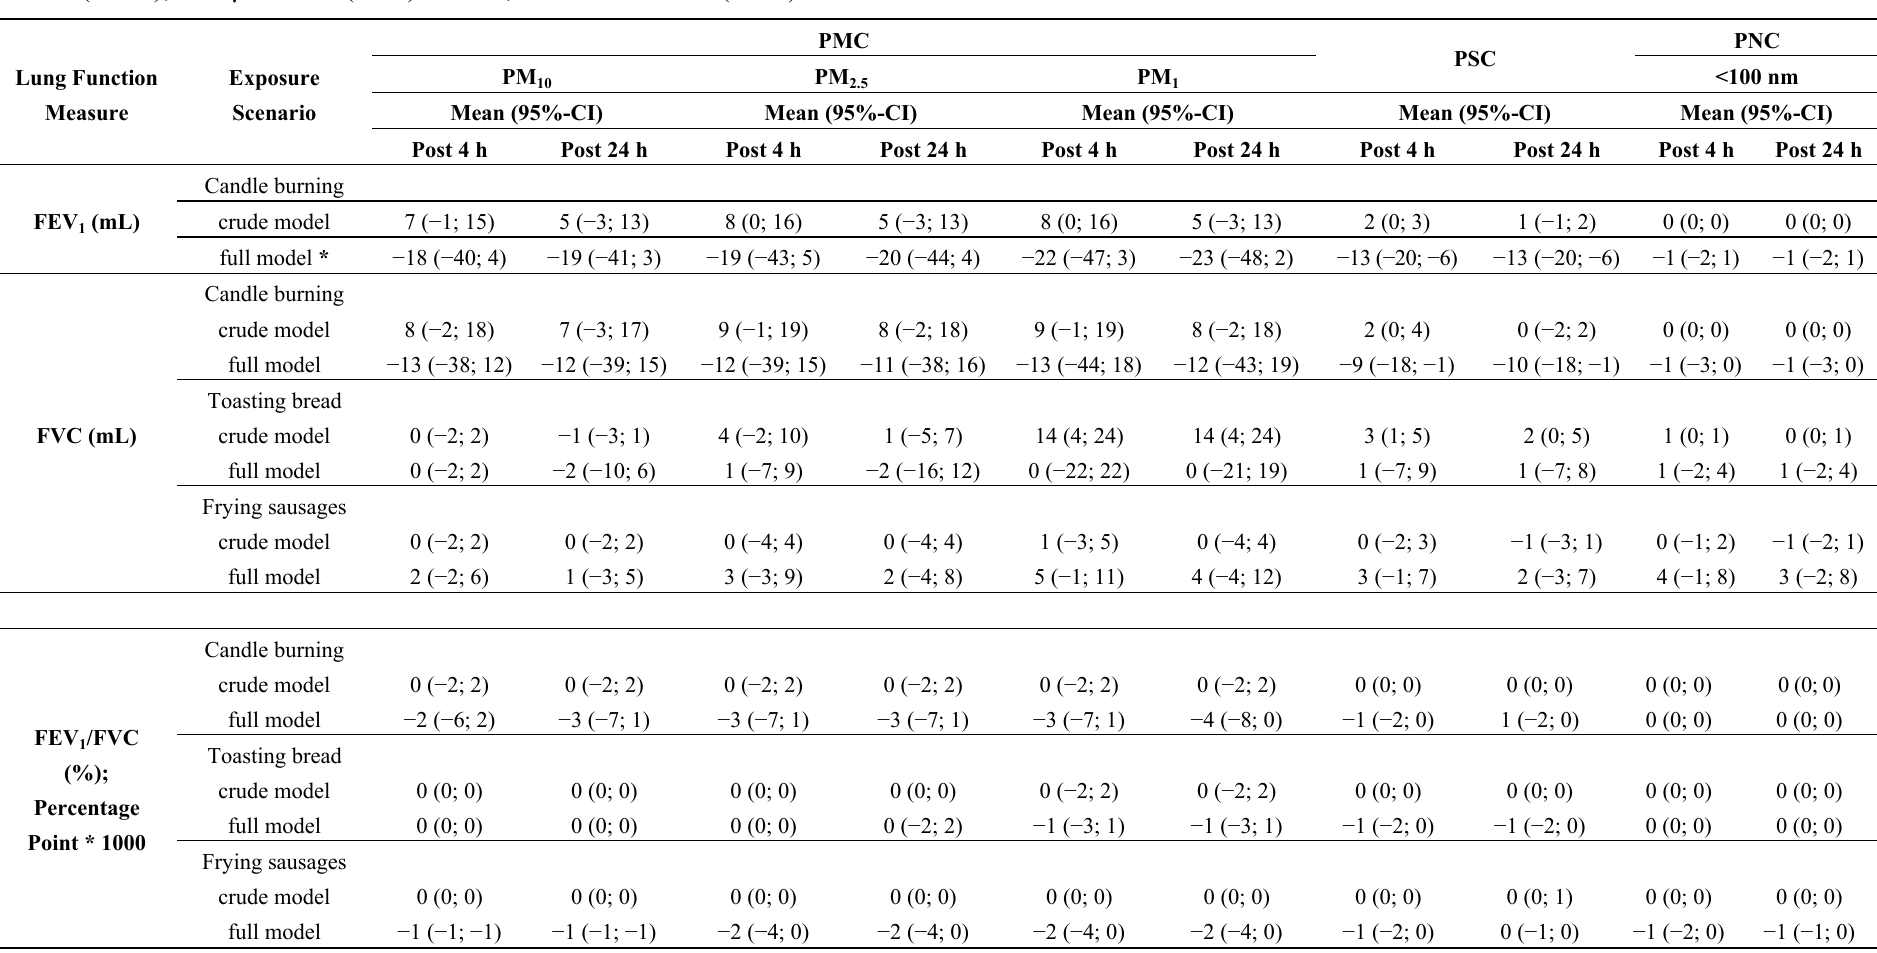
Table 4. Mean effect estimates and 95% Confidence Intervall (CI) for changes (difference) associated with an increase in particulate metrics post 4 h and 24 h post exposure and for different exposure scenarios for PMC, PSC and PNC. Changes refer to an increase of 10 µg/m